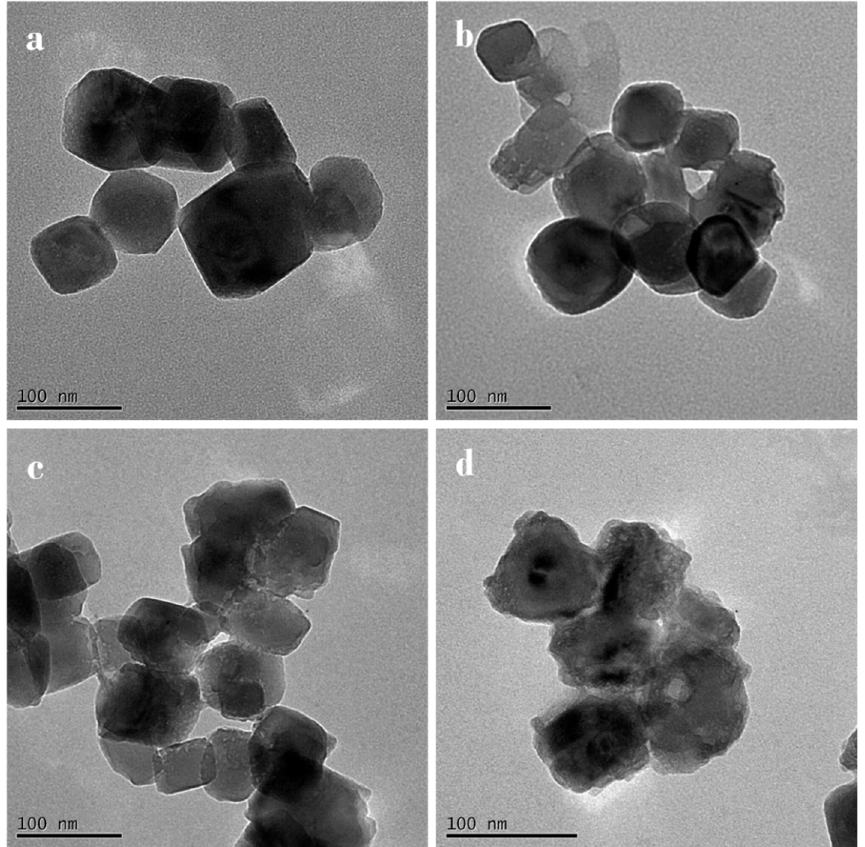
Figure 1. TEM characterization: ( a ) CCNs, ( b ) CCNs-HSA, ( c ) CCNs-NH 2, and ( d ) CCNs-NH 2 -HSA. Scale bar = 100